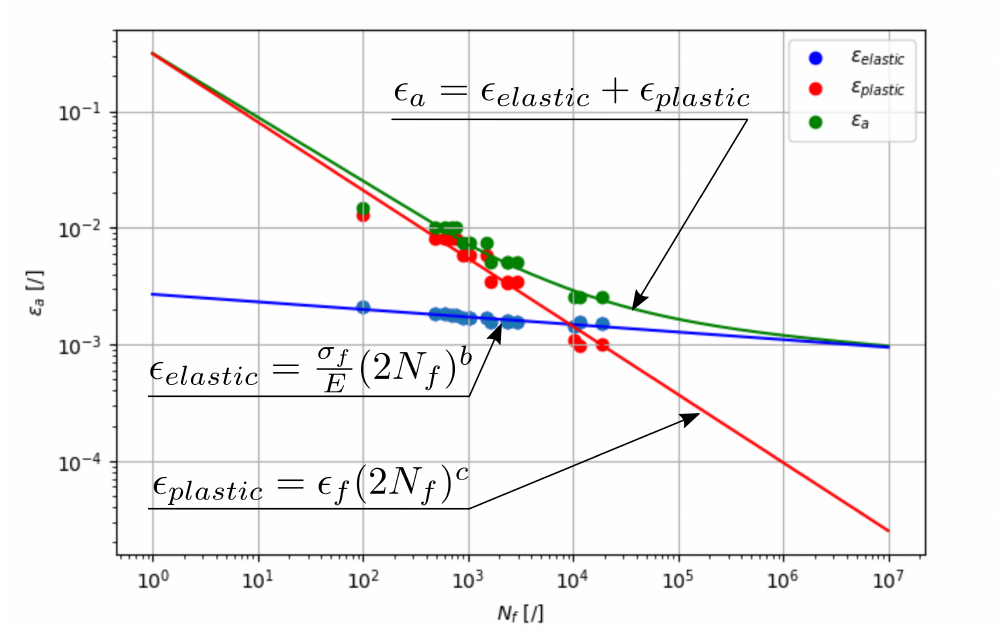
Figure 4. The Coffin-Manson model, see Equation